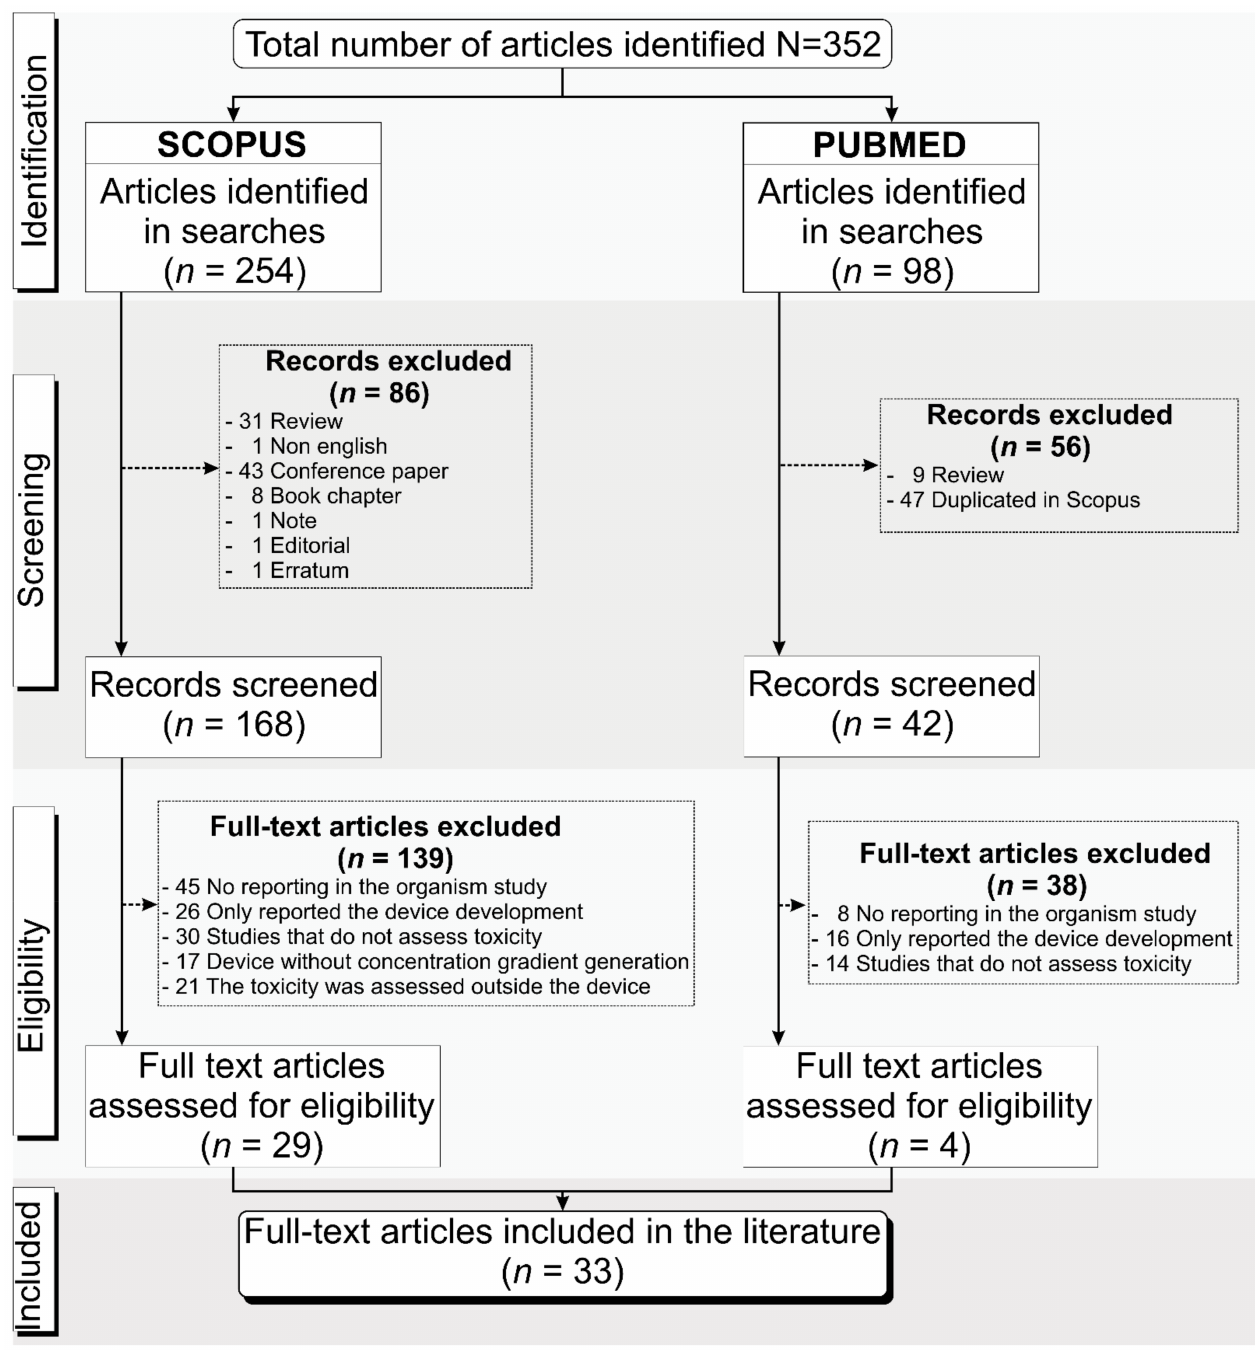
Figure 1. Schematic representation of the process for articles’ identification, screening, and eligibility for inclusion in this systematic review following the PRISMA